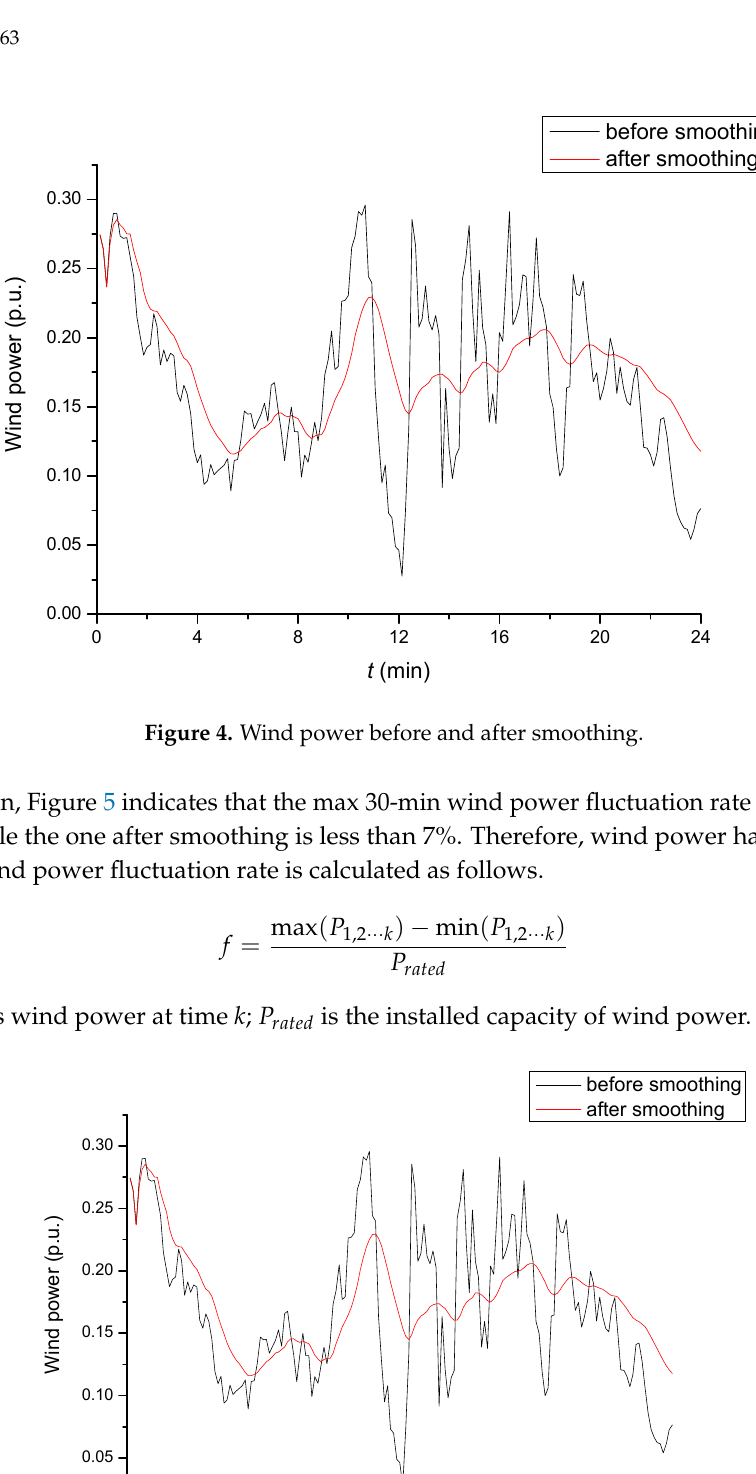
Figure 5. Wind power fluctuations before and after smoothing.